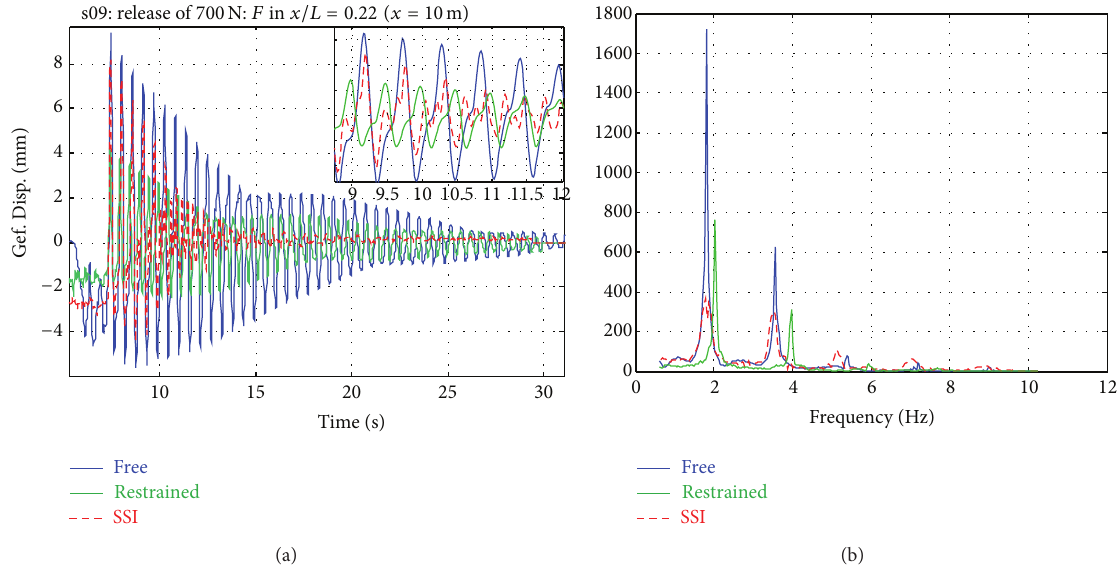
Figure 5: (a) Displacement and (b) associated spectrum at 37.8 m on the free, constraint, and SSI cable no. 1.